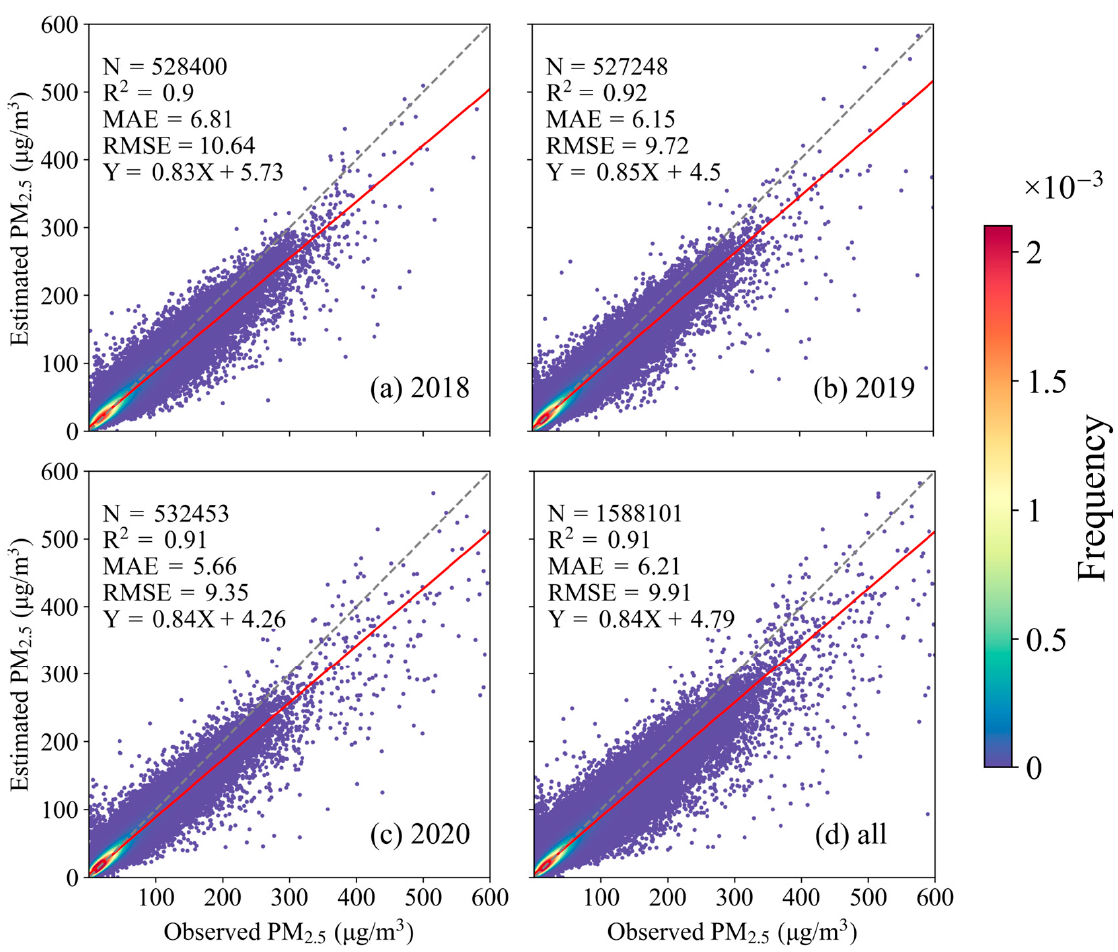
Figure 2. Density scatter plots of the validation results for daily estimated PM 2.5 concentrations (( a – c ) for each year and ( d ) for the total). The dash line in grey denotes the 1:1 line and the solid line in red denotes the linear regression line.